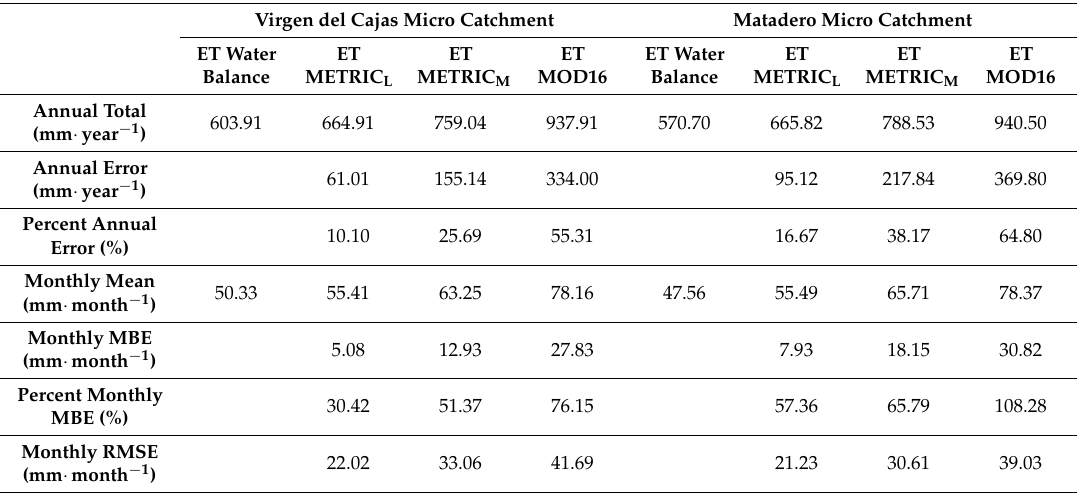
Table 5. Comparison of METRIC L , METRIC M and MOD16 retrievals with ET from the water balance in the micro catchments (annual and monthly scale). For the micro catchments locations, refer to Figure